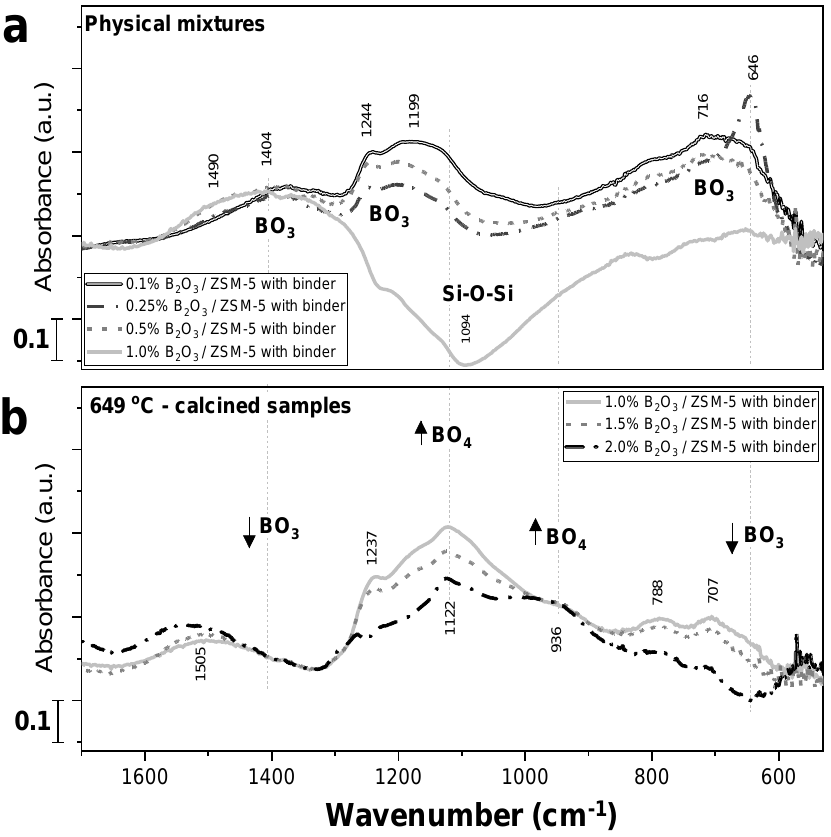
Figure 5. FTIR spectra in the borate region for ( a ) physical mixtures (Samples #5-8), and ( b ) 649 °C – calcined boron trioxide with ZSM-5 (Samples #9-11).